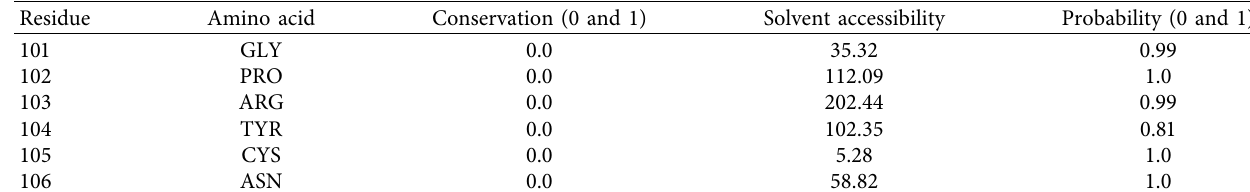
Table 3: Predicted binding residues that interact with the ligand